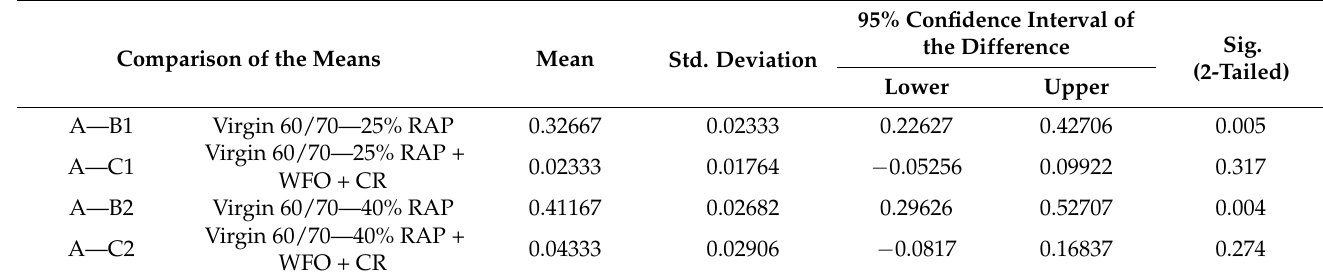
Table 18. The significant difference in the group means for the dynamic creep of the virgin asphalt with RAP and the recycled asphalt mixtures at 40 ◦ C.